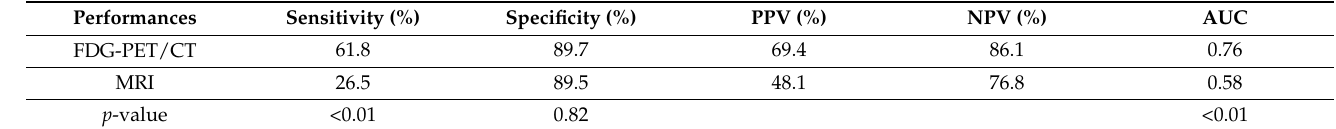
Table 3. Comparison of FDG-PET/CT and MRI performances in the para-aortic area.